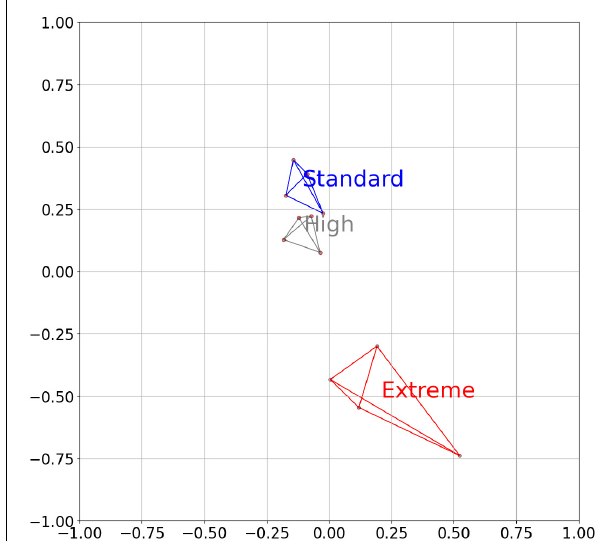
FIGURE 3 | An MDS plot of the individual cows based on the relative abundance of the linkage targets across all significantly changed bins of the rumen metagenome. The separation score between the Standard and the Extreme is 2.11. The axes are arbitrary values, resulting from the reduction of the multidimensional space of correlation similarities into two